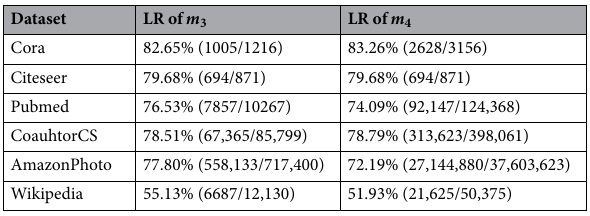
Table 3. LR of dataset.